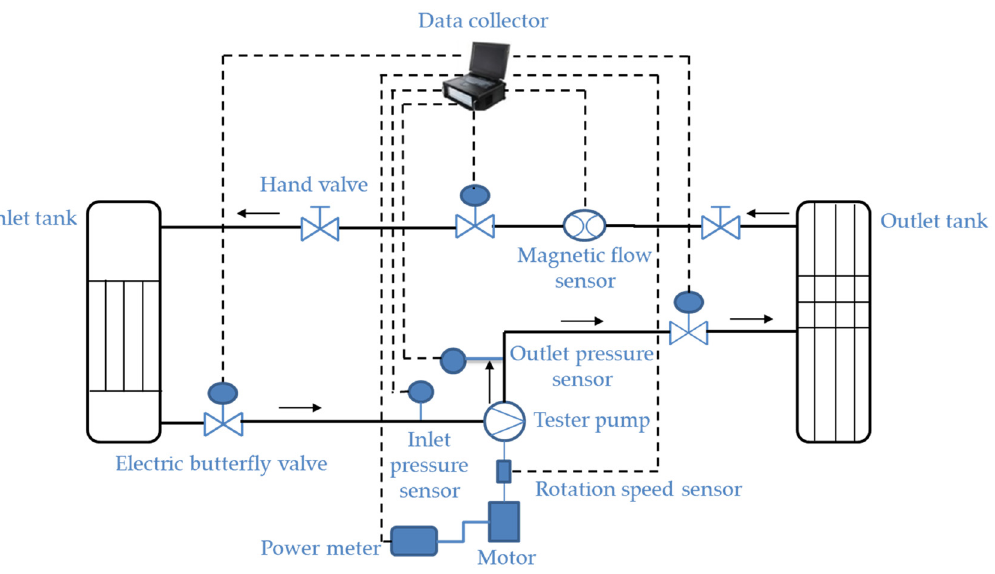
Figure 1. The diagram of experimental system for measuring the centrifugal pump efficiency.